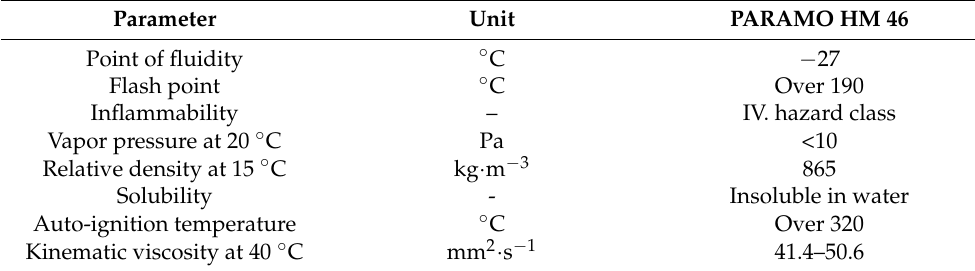
Table 1. Basic characteristics of PARAMO HM 46